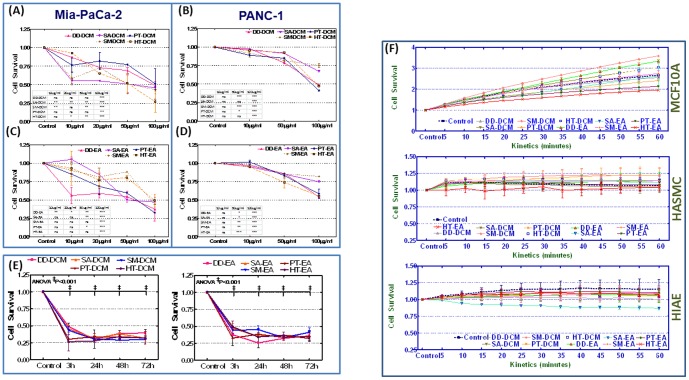
Line plots of CyQUANT-NF cell proliferation assay showing dose dependent inhibition of cell survival with 10, 20, 50 and 100 µg/ml of (A & B) dichloromethane (DD-DCM, SA-DCM, SM-DCM, PT-DCM, HT-DCM) fractions or (C & D) ethyl acetate (DD-EA, SA-EA, SM-EA, PT-EA, HT-EA) fractions in MiaPaCa-2 and Panc-1 cells.The cells exposed to the seaweed polyphenols were assessed for cell proliferation 3 h post treatment. Dose associated inhibition of cell proliferation for each polyphenol fractions were compared to untreated controls using two-way ANOVA with Bonferonii post-hoc test and a P value of <0.05 is considered statistically significant. (E) Line plots of DD-DCM, SA-DCM, SM-DCM, PT-DCM, HT-DCM, DD-EA, SA-EA, SM-EA, PT-EA and HT-EA exposed MiaPaCa-2 cells showing significant and sustained (3, 24, 48 and 72 h) inhibition of cell proliferation. (F) Line plots of DD-DCM, SA-DCM, SM-DCM, PT-DCM, HT-DCM, DD-EA, SA-EA, SM-EA, PT-EA and HT-EA exposed normal human MCF10A, HASMC and HIAE cells showing consistent cell survival 24 h after treatment. Compared to untreated controls, all DCM and EA fractions revealed no significant inhibition of cell proliferation all three cell lines investigated. Time-line in the line-plots shows the fluorescence (480 nm excitation and 520 nm emission) measurements continuously up to 60 minutes.